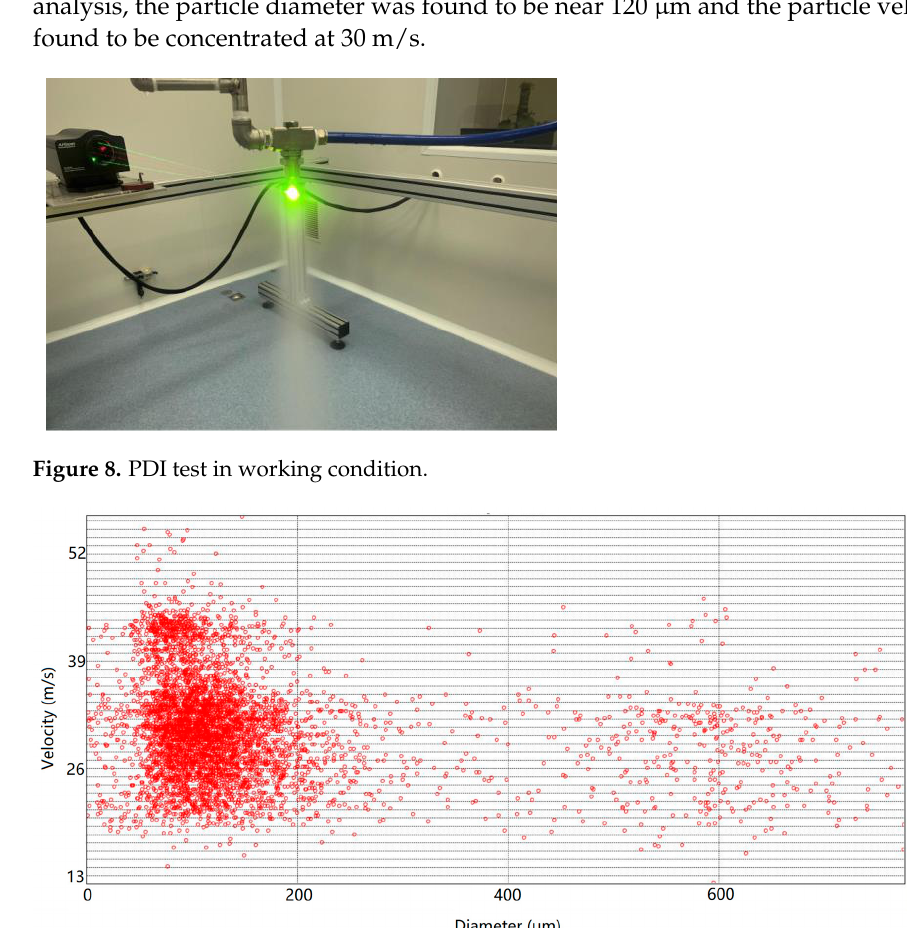
Figure 9. Test results of the atomized particles under pressure of 0.9 bar.